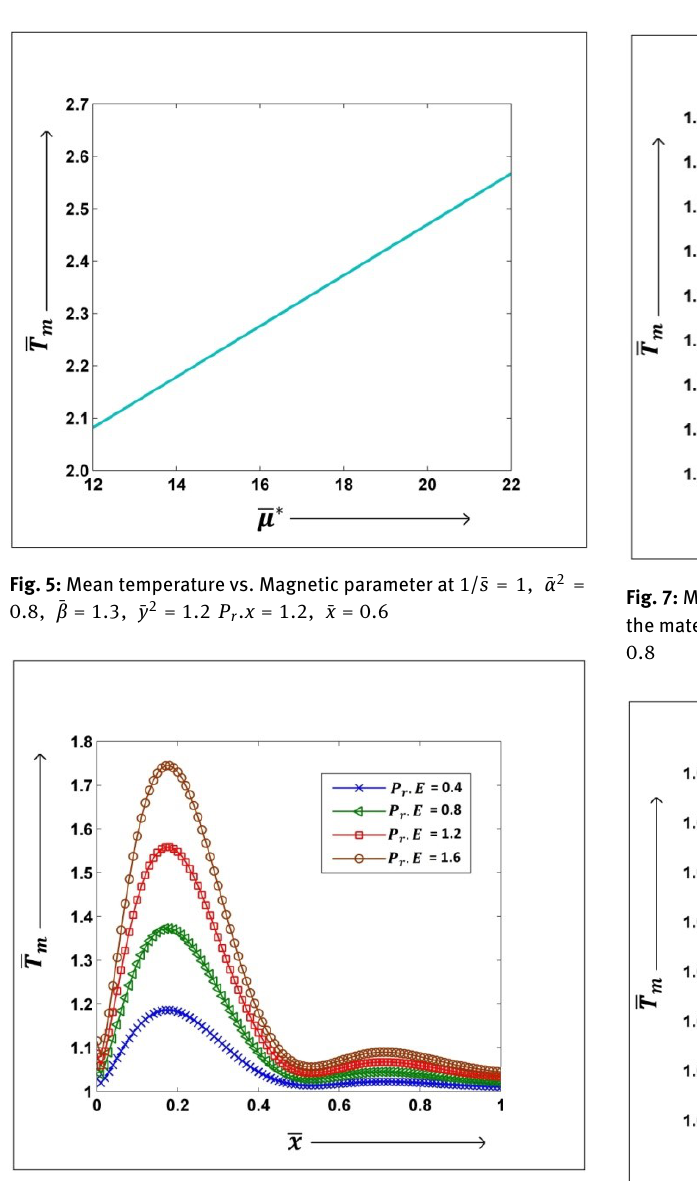
Fig. 6: Mean temperature vs. bearing length for various values of the thermal parameter at 1/¯ s = 0.5, ¯ α 2 = 1.2, ¯ β = 1.3, ¯ γ 2 = 1.2 terial parameter (¯ α 2 ). It is seen that for a small value of slip, i.e. 1/¯ s ≤ 0.3, the material parameter doesn’t affect the mean temperature but for a large value of slip, i.e.